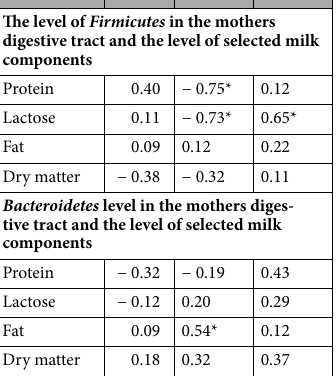
Table 3. Correlation coefficients between the studied groups of bacteria in the digestive system of ewes and the composition of their milk. * p < 0.05.